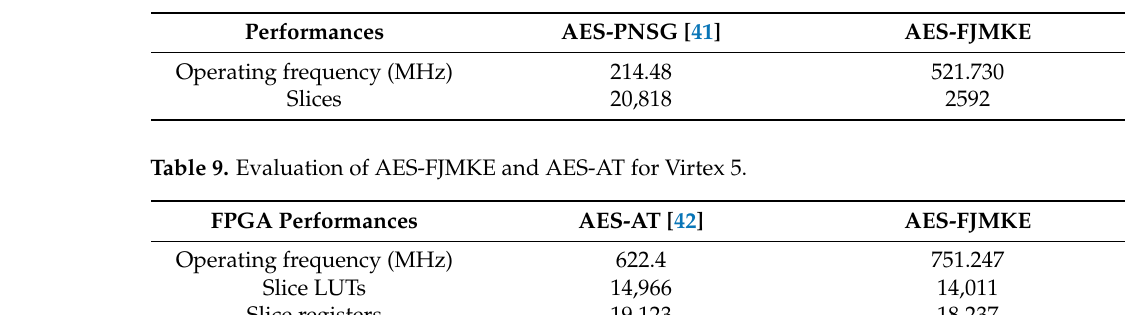
Table 11. Comparison of AES-FJMKE and ISAES for Spartan 3. FPGA Performances